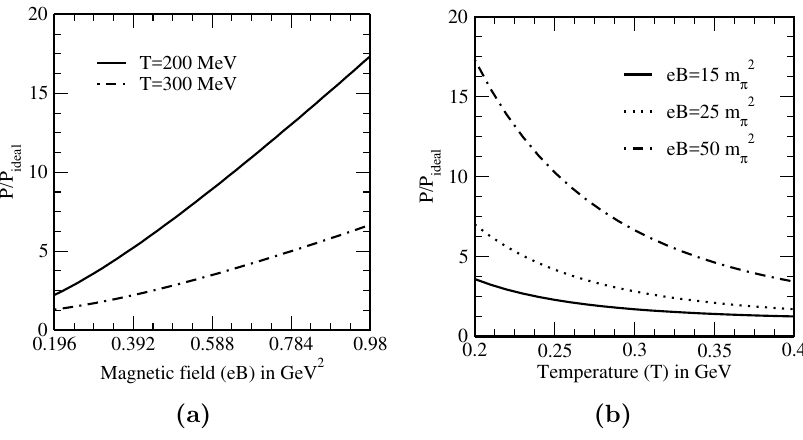
Figure 4 . The variation of QCD pressure normalized by its ideal value as a function of magnetic (cid:12)eld at di(cid:11)erent temperatures (a) and as a function of temperature at di(cid:11)erent strong magnetic (cid:12)elds